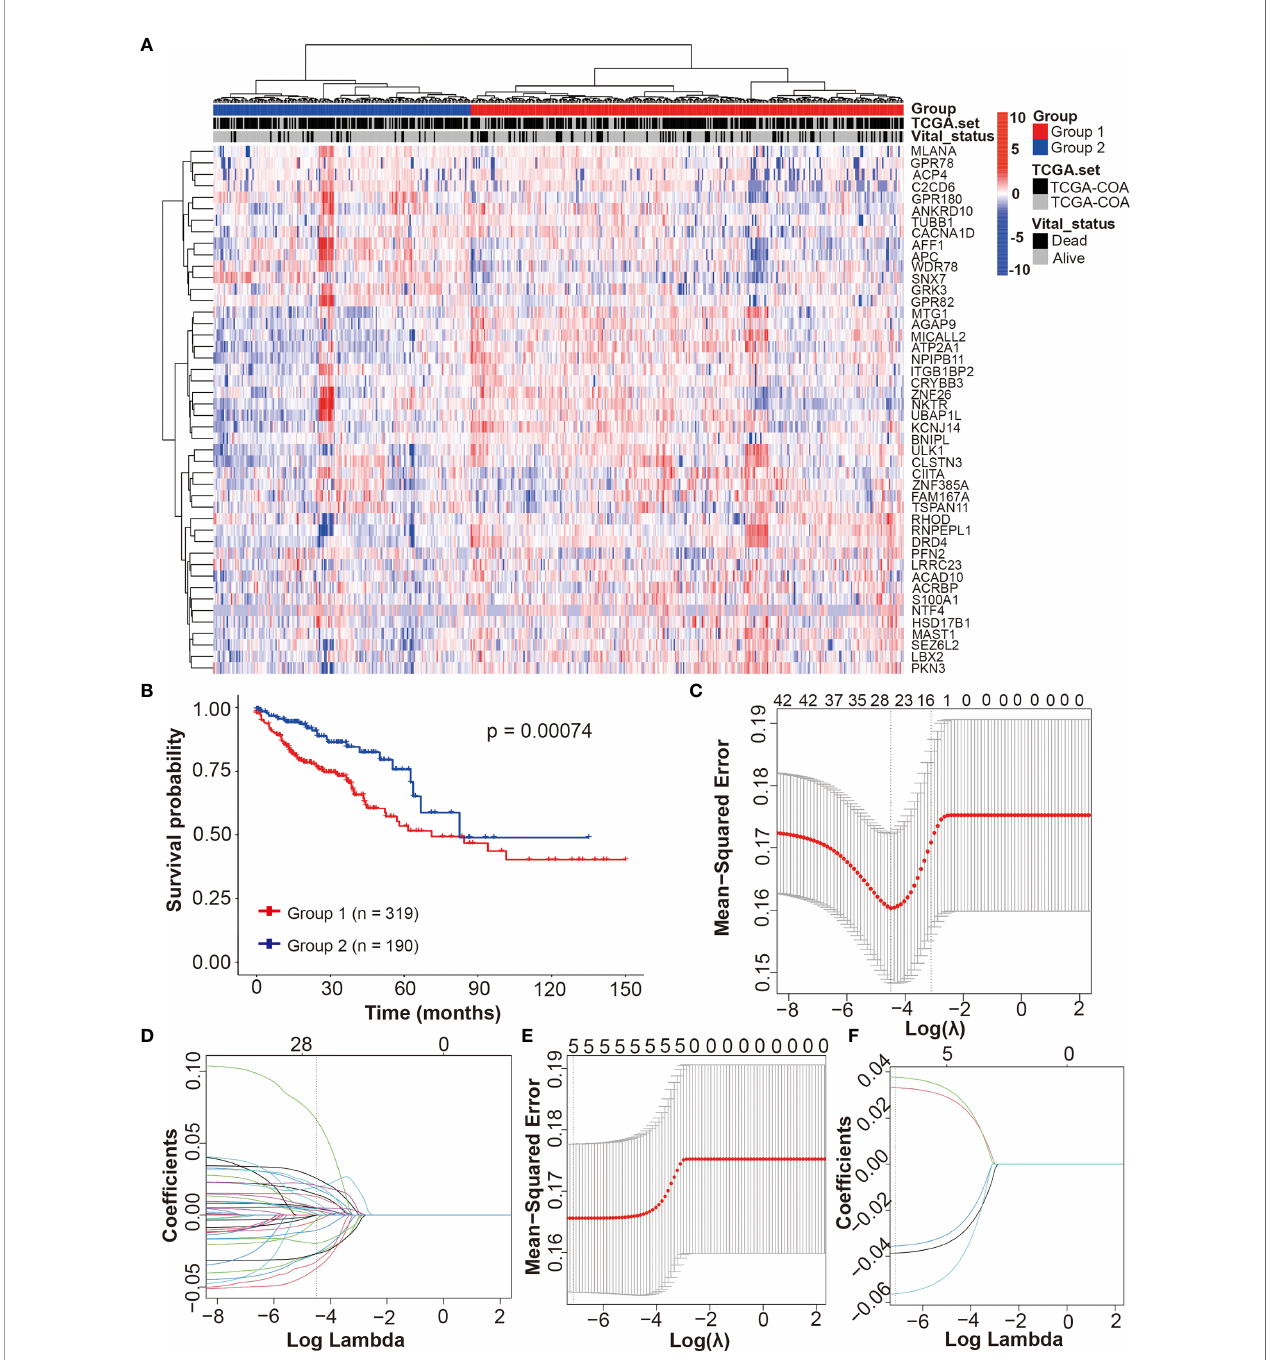
FIGURE 5 | Development of the drug-resistant score model (DRSM) by using DRGs associated with 5-Fu resistance. (A) Unsupervised clustering of 698 tumor samples using the expression data of 46 DRGs in TCGA-CRC dataset revealed two molecular subtypes (group1, n = 319; group2, n = 190). (B) Univariate analysis for groups (1 or 2) and their correlation with clinical outcome [overall survival (OS)] in TCGA-CRC cohort. (C) Optimal parameter (lambda) selection in the LASSO model using 5-fold cross-validation via minimum criteria for 46 DRGs. (D) LASSO coef fi cient pro fi les of the 46 DRGs at the optimal lambda value selected using 5- fold cross-validation. (E) Optimal parameter (lambda) selection in the LASSO model using 5-fold cross-validation via minimum criteria for 5 DRGs after fi ltering using multivariate Cox analysis. (F) LASSO coef fi cient pro fi les of the 5 DRGs at the optimal lambda value selected using 5-fold cross-validation. TCGA, the cancer genome atlas; DRSM, drug-resistant score model; DRGs, drug-resistant genes; 5-Fu, 5- fl uorouracil; CRC, colorectal cancer; OS, overall survival; LASSO, least absolute shrinkage and selection